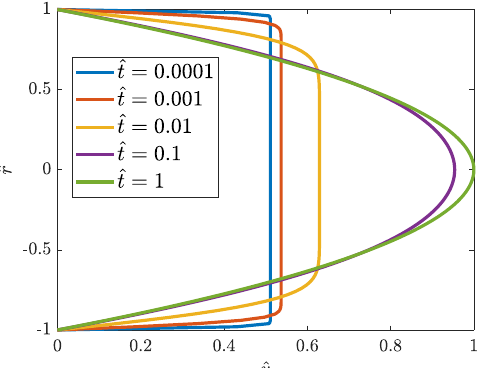
Figure 9. Development of velocity profile in AT accelerated flow driven by an abruptly imposed constant volume flux.